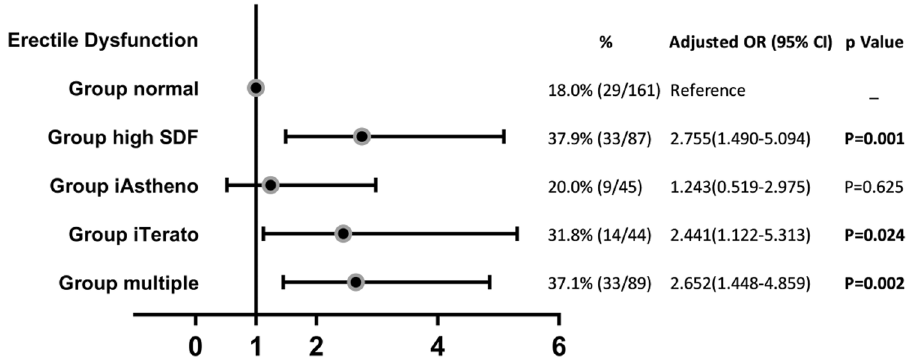
Figure 2. Erectile dysfunction incidence of each group are represented.